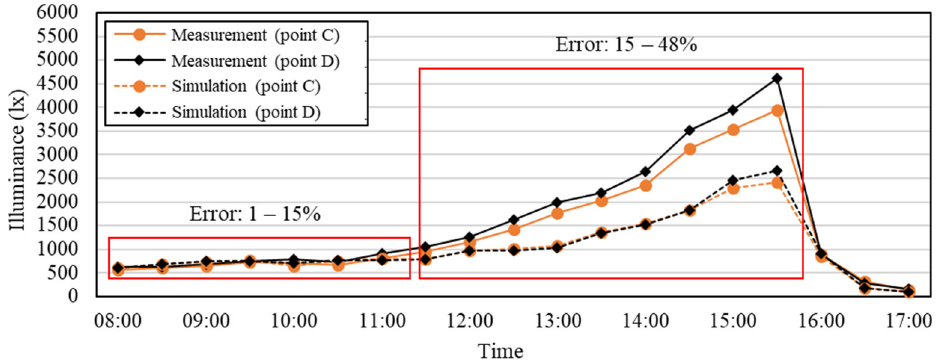
Figure 14. Illuminance comparison of simulation and measurement. (The opening is facing west without expanded metal mesh).